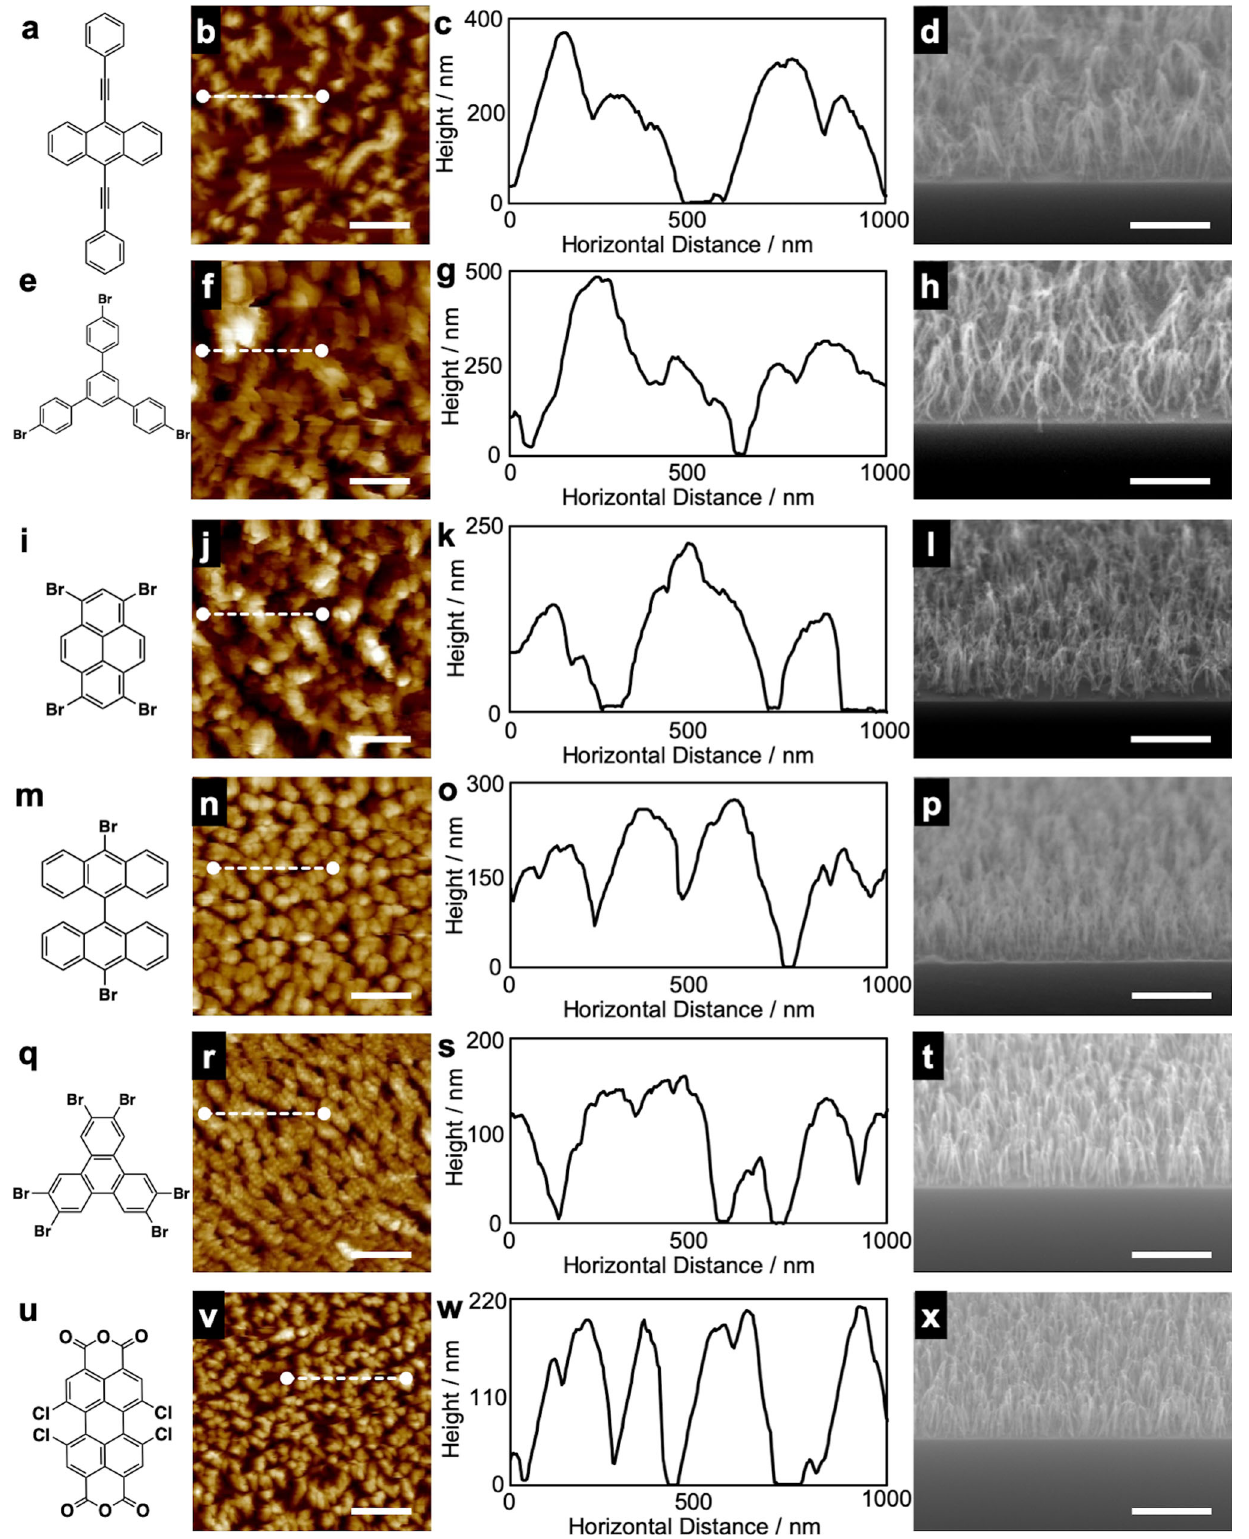
Fig. 3 Nanowires from various aromatic compounds isolated by dry process. a , e , i , m , q , u Chemical structure, b , f , j , n , r , v AFM topographic images and c , g , k , o , s , w height pro fi les along white dashed lines, and d , h , l , p , t , x SEM images of nanowires fabricated via irradiation of vapor-deposited fi lms of a – d 450 nm 9,10-bis(phenylethynyl)anthracene (BPEA), e – h 500 nm 1,3,5-Tris(4-bromophenyl)benzene (TBPB), i – l 250 nm 1,3,6,8-tetrabromopyrene (TBP), m – p 300 nm 10,10 ′ -dibromo-9,9 ′ -bianthracene (DBBA), q – t 200 nm 2,3,6,7,10,11-hexabromotriphenylene (HBT), u – x 220 nm 1,6,7,12-tetrachloro- 3,4,9,10-perylenetetracarboxylic dianhydride (PTCDA-Cl 4 ). Scale bars represent 500 nm. Irradiation conditions: 450 MeV 129 Xe 23 + at 1.0 × 10 11 cm − 2 .